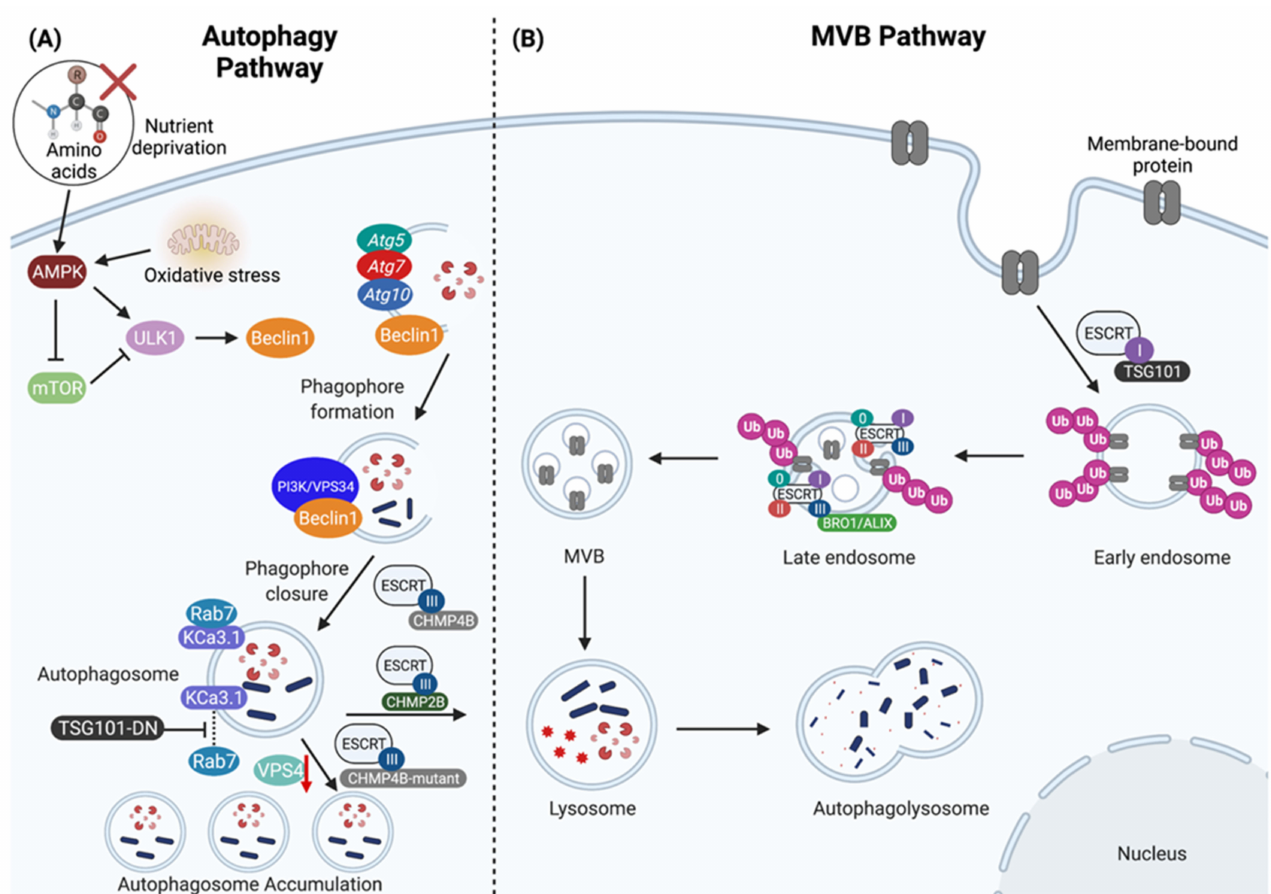
Figure 1. The regulation of lysosomal-mediated degradation through the autophagy and multivesicular body (MVB) pathways. ( A ) The autophagy pathway is induced by AMP-activated protein kinase (AMPK) and inhibited by mammalian target of rapamycin (mTOR). Nutrient deprivation and oxidative stress promote AMPK activity, in turn activating the UNC-51 like kinase 1 (ULK1) complex, which then recruits Atg5 , Atg7 , Atg10 and phosphorylates Beclin1 to promote further recruitment of the PI3K/VPS34 complex to enable phagophore formation. CHMP4B is a core component of ESCRT-III that further assists in mediating phagophore closure. The fusion between the autophagosome with the lysosome is mediated by CHMP2B to form the autophagolysosome, which contains cytosolic content destined for degradation. The absence of functional CHMP4B (CHMP4B-mutant) and either knock-down of VPS4 expression (red down arrow) or expression of dominant negative VPS4 or TSG101 (TSG101-DN) prevents autophagosome-lysosome fusion resulting in autophagosome accumulation, and failure to degrade cargo such as the calcium-activated potassium channel 3.1 (KCa3.1). ( B ) The biogenesis of MVBs and sorting of ubiquitinated cargo is regulated through the ESCRT pathway. The ESCRT machinery are grouped into four categories: ESCRT-0, ESCRT-I, ESCRT-II, and ESCRT-III. TSG101 is a member of the ESCRT-I complex that facilitates the sorting of ubiquitinated membrane-bound proteins into early endosomes. The ESCRT machinery sequentially assembles on the late endosome where it mediates the biogenesis of MVB vesicles and the sorting of ubiquitinated membrane-bound proteins into intralumenal vesicles (ILVs), and the ESCRT-III complex is involved in the recruitment of BRO1/ALIX to assist in the biogenesis of ILVs. After the biogenesis of MVBs and the sorting of ubiquitinated proteins into ILVs, MVBs are then routed into the lysosome for degradation. Created with